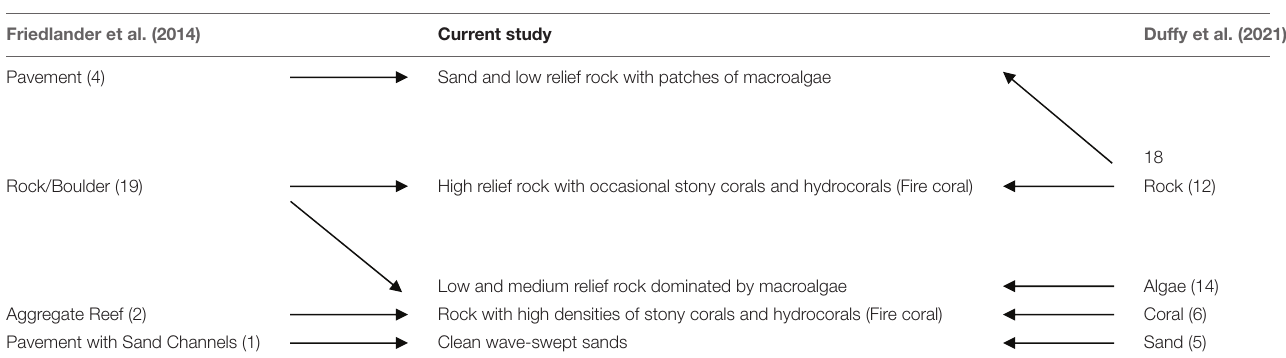
TABLE 3 | Relationship between habitat descriptions from the historical datasets and the current predictive